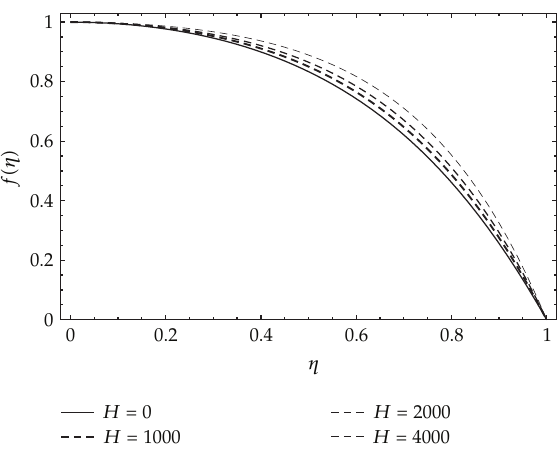
Figure 2: DTM solution for velocity in convergent channel for Re (cid:8) 100 and α (cid:8) − 2 . 5 o .